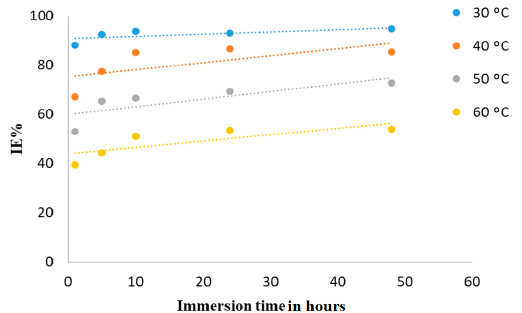
Figure 9. IE % vs. different immersion times at various temperatures with a concentration of 0.5 mM in 1N H 2 SO 4 solution.